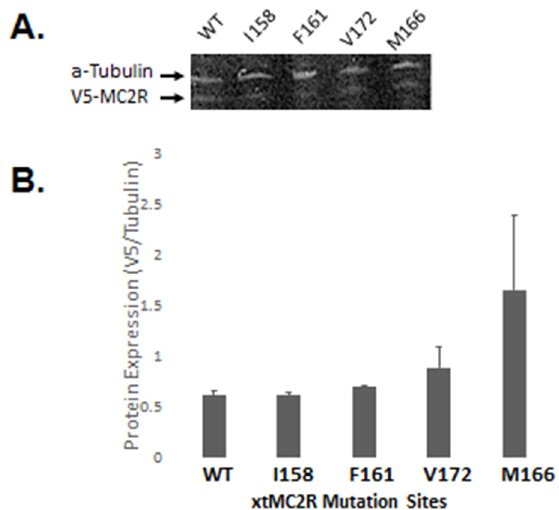
Figure 4. Western blot analysis - protein expression of xt MC2R single alanine mutants, I158 / A, F161 / A, V172 / A, and M166 / A. ( A ) This figure shows the overall protein expression of WT and single alanine mutants xMC2R I158 / A, F161 / A, V172 / A, and M166 / A transiently transfected in CHO cells with cMRAP. Whole cell lysates were prepared in in RIPA bu ff er and 500 µ g total protein was loaded into a 4–20% Mini-PROTEAN ® TGX ™ Precast Protein Gels (BioRad, Herculus, CA, USA) to perform western blot analysis. a-Tubulin was used as a loading control. ( B ) This figure shows the quantification of overall WT hMC2R or mutant expression. V5 tagged receptor expression was normalized to a-Tubulin and compared using a one-way ANOVA.